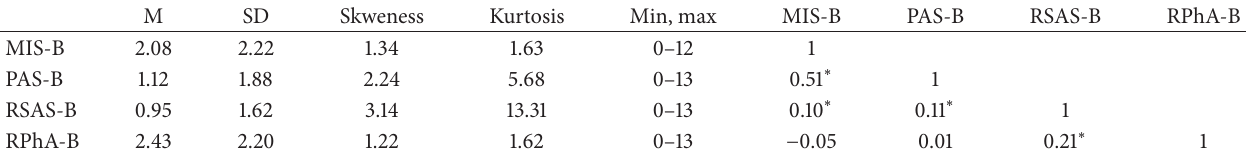
Table 1: Descriptive statistics and Pearson’s correlation coefficients for the short forms of the Wisconsin Schizotypy